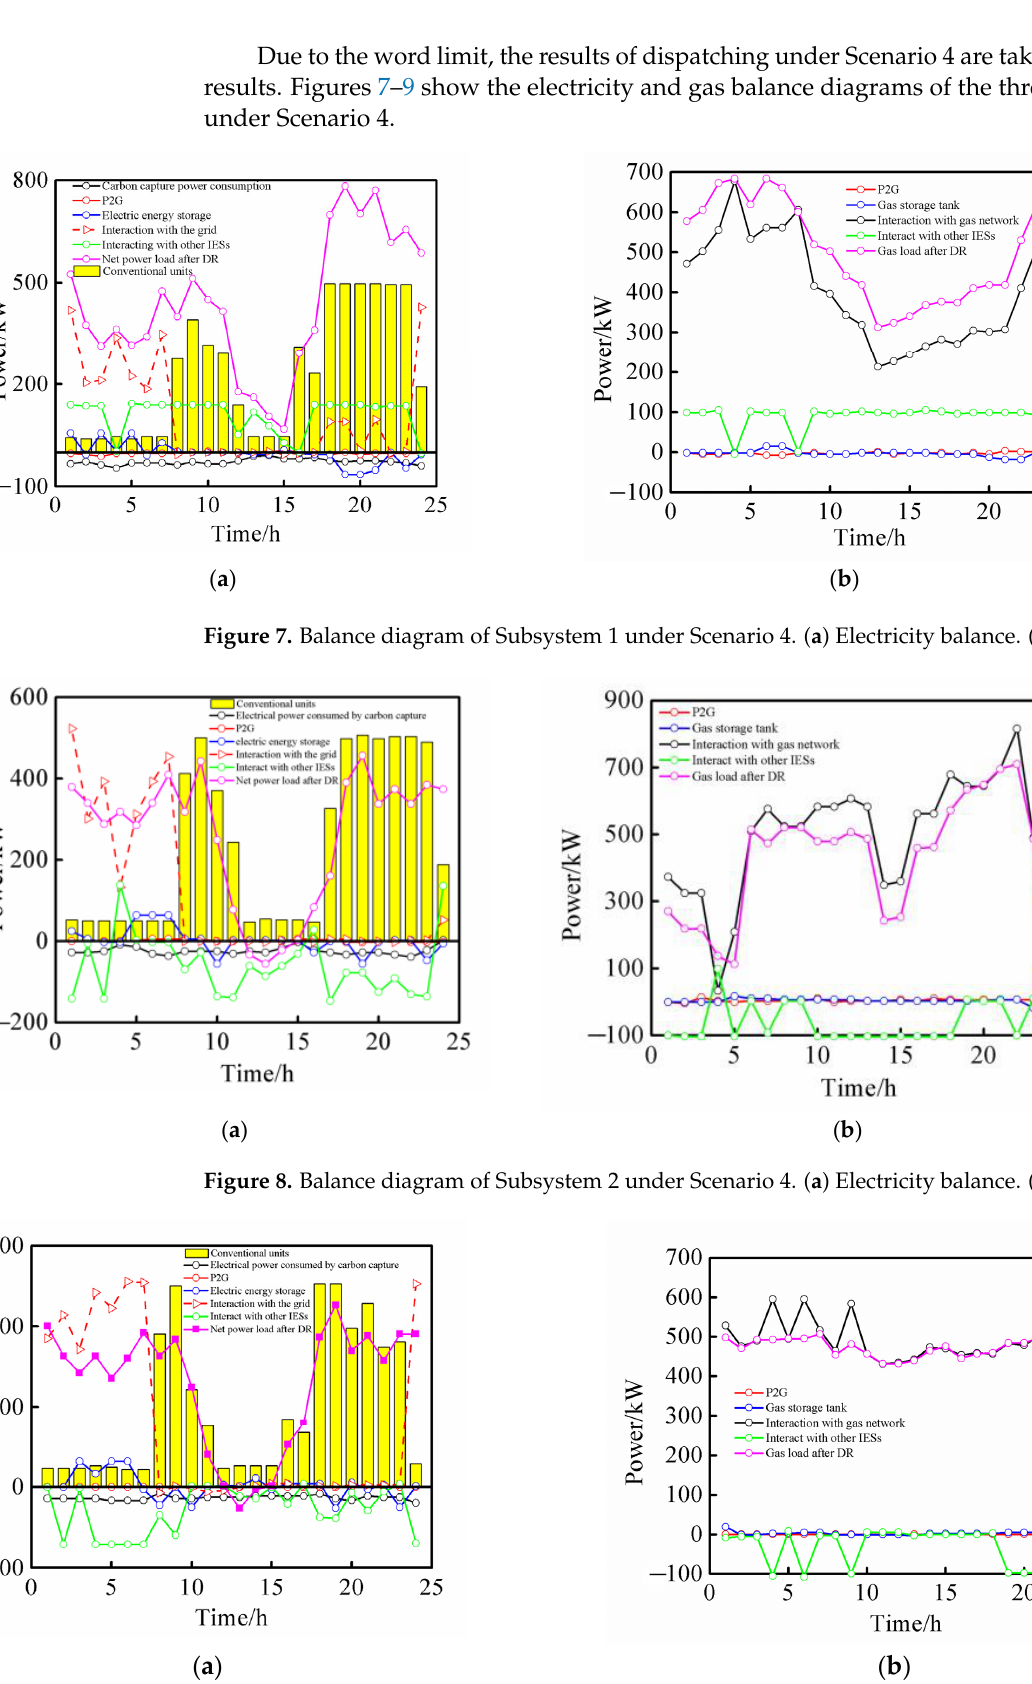
Figure 6. Iterative convergence of the robust optimization model under Scenario 4.